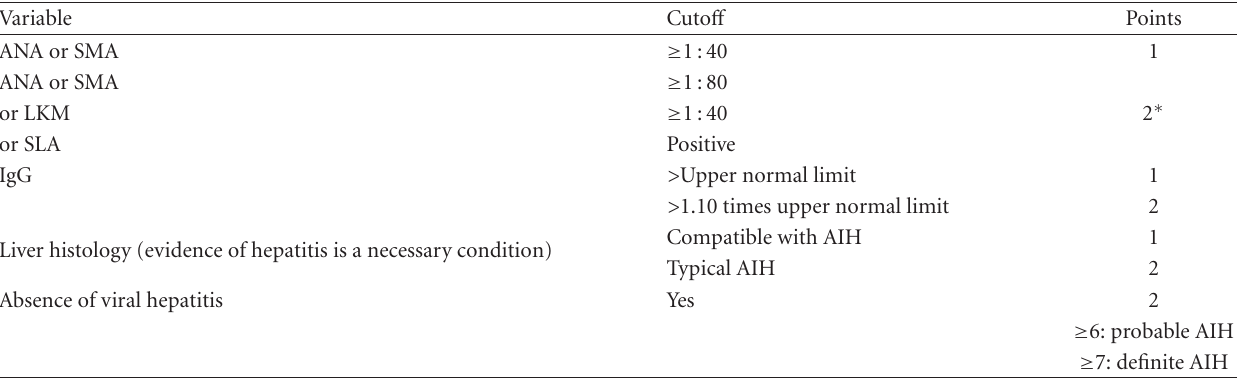
Table 2: Simplified diagnostic criteria for autoimmune